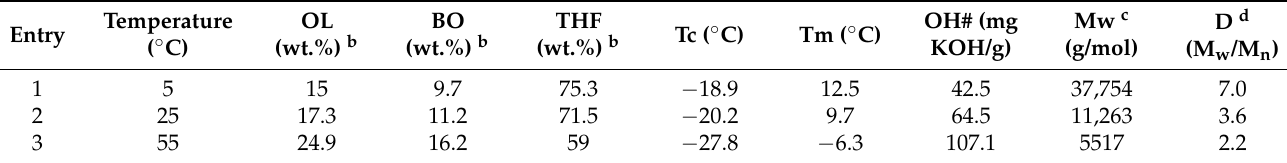
Table 3. Influence of the temperature on the LBP microstructure a .